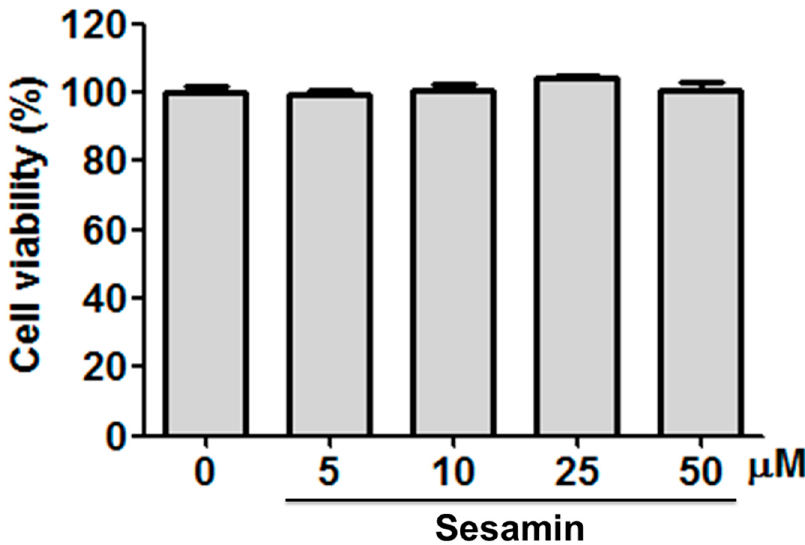
Figure 1. The cell viability (%) of sesamin on human skin fibroblasts and sesamin did not exhibit toxicity to the cells.